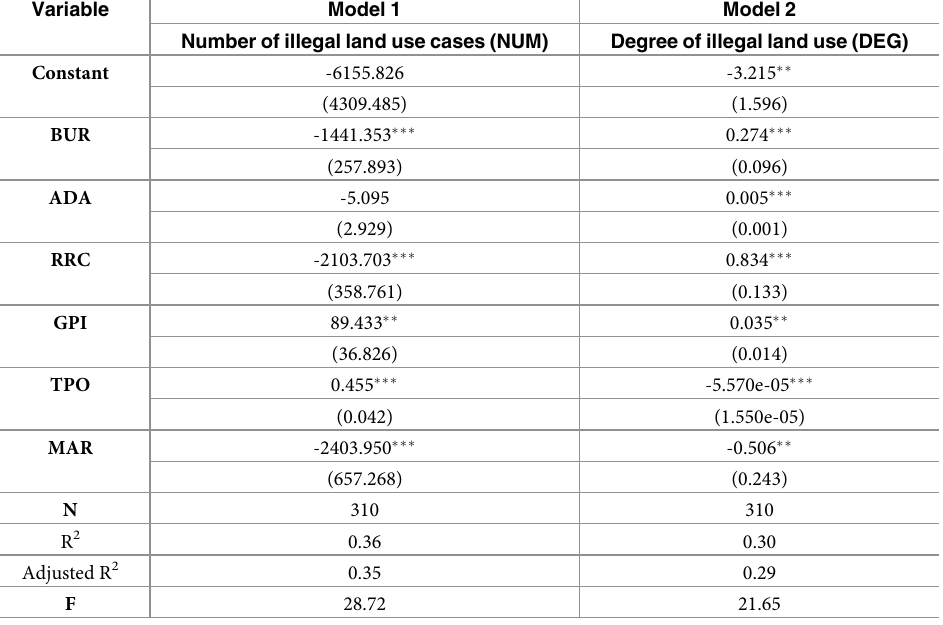
Table 3. Estimated results of the